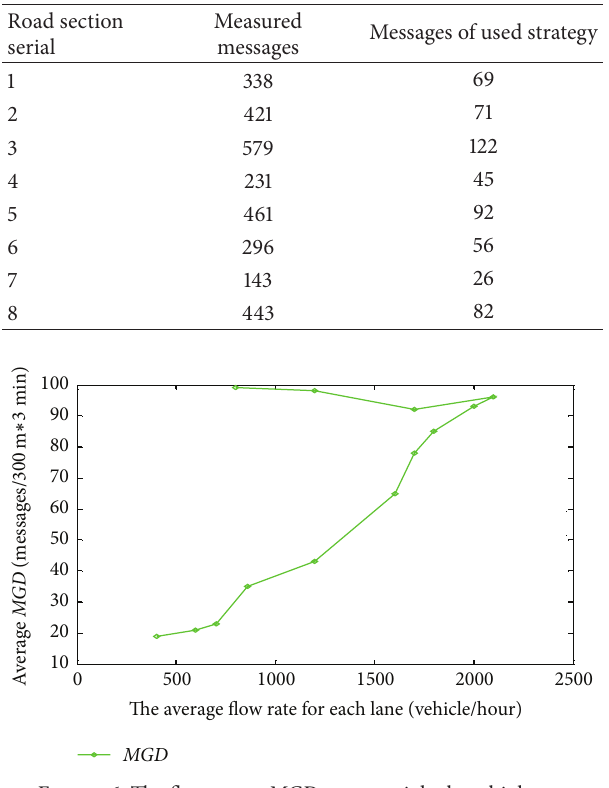
Figure 6: The flow rate— MGD —on an eight-lane highway.